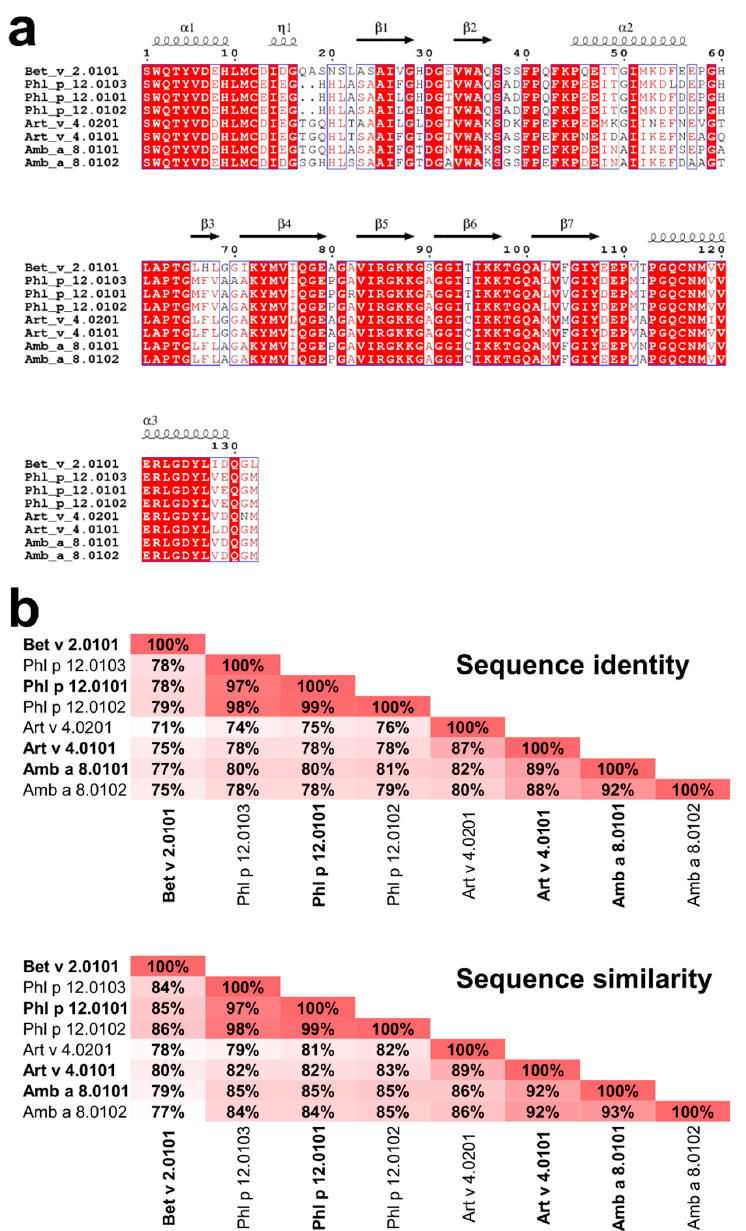
Figure 2. Comparison of Amb a 8, Art v 4, Bet v 2, and Phl p 12 sequences. All isoallergens reported by the World Health Organization (WHO) and International Union of Immunological Societies (IUIS) Allergen Nomenclature Sub-committee (allergen.org) are shown. ( a ) Sequence alignment generated using Clustal Omega [17] and ESPript [18]. ( b ) Sequence identities and similarities between the profilins as calculated by SIAS (http: // imed.med.ucm.es / Tools / sias.html) using the default